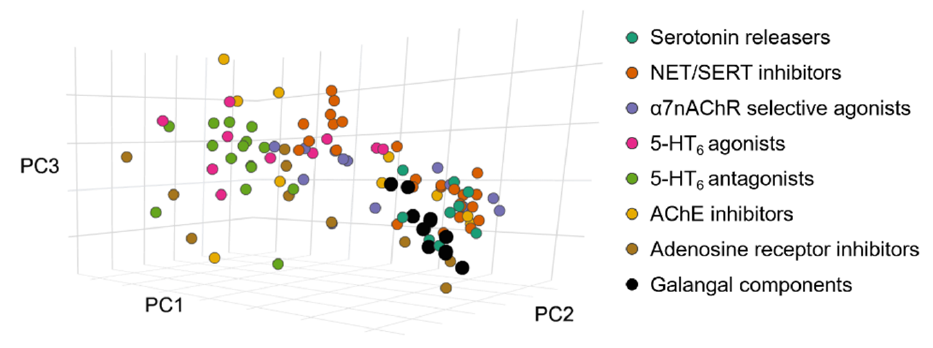
Figure 5. Localization of the galangal compounds in chemical space compared to known passive and P-gp substrates, as well as non-diffuser molecules, using ChemGPS-NP. As the compounds responsible for the psychostimulant effects are unidentified, the position of galangal compounds in chemical space were investigated beside reference molecules of different molecular mechanism. In Figure 6, it can be seen that the molecules of different sets are not separated in chemical space. For example, 5-HT 6 agonists and antagonists are clustered together (light green and pink spots), while NET/SERT inhibitors (orange spots) are placed in two distinct groups based on the number of aromatic rings in the structures. Most galangal compounds are clustered together with monocyclic NET/SERT inhibitors and serotonin release enhancers. Based on the work of Buonfiglio et al., molecules with Euclidean distances smaller than 1 in the multidimensional chemical space show similarity; thus, this cutoff value was applied in searching the reference sets [27]. The results are summarized in Table 2.